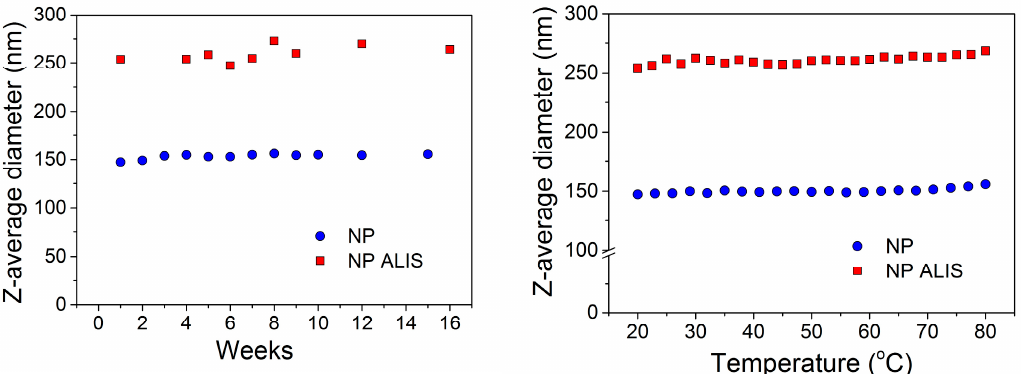
Figure 2 . Time stability ( left ) and temperature stability ( right ) of NP and NP ALIS measured by DLS.